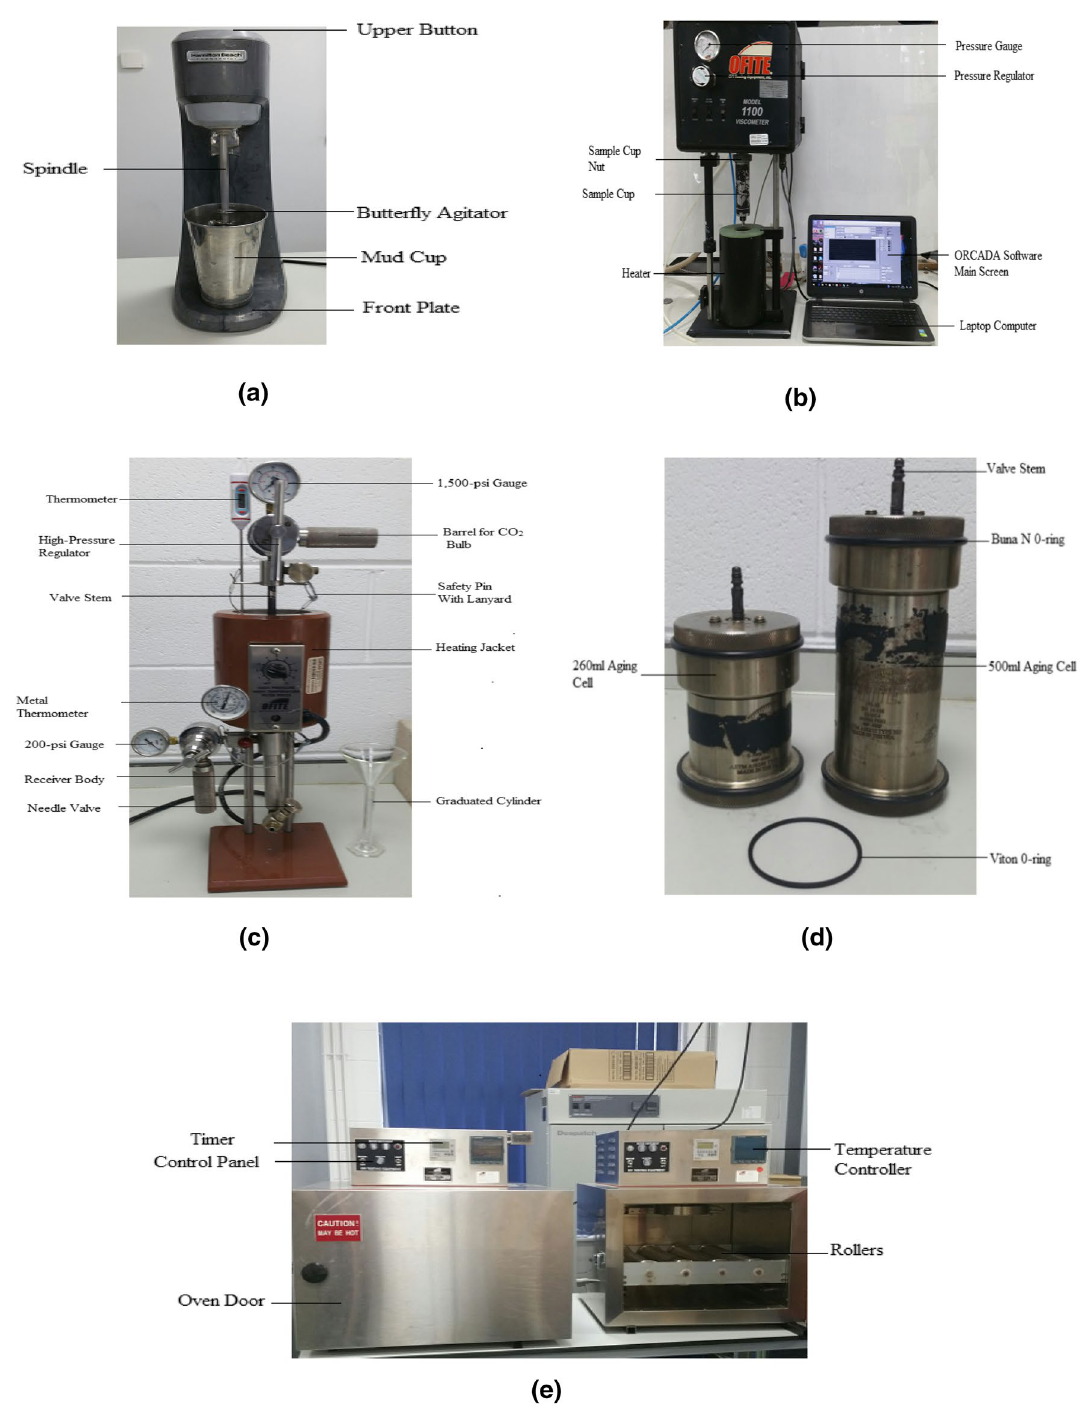
Fig. 3 Experimental apparatuses: a Hamilton beach mixer; b Model 1100 viscometer and a laptop computer; c HTHP filter press; d aging